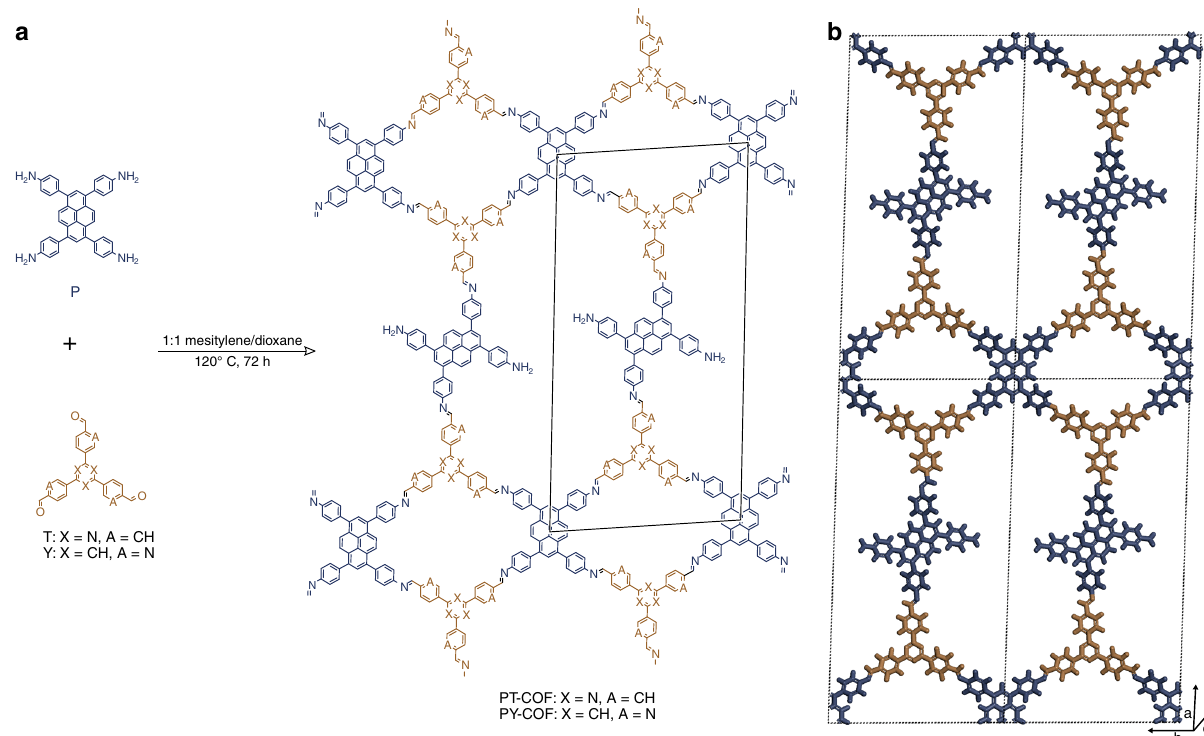
Fig. 2 Structure of PT- and PY-COFs. a Synthesis and molecular structure of PT- and PY-COFs. The in-plane unit cell is outlined in black. b Illustration of the COF structure model with bex toplogy (viewed perpendicular to the ab